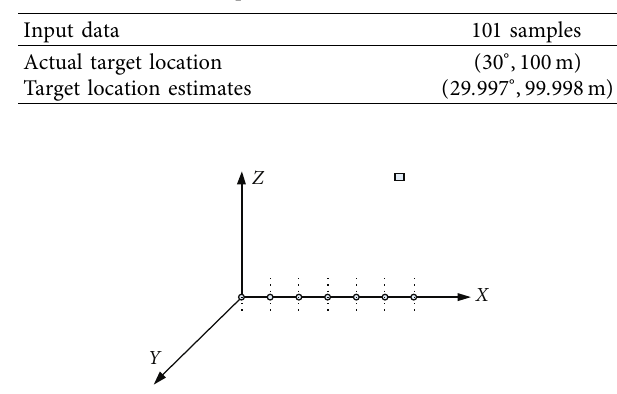
Table 3: Sample results of FEKO